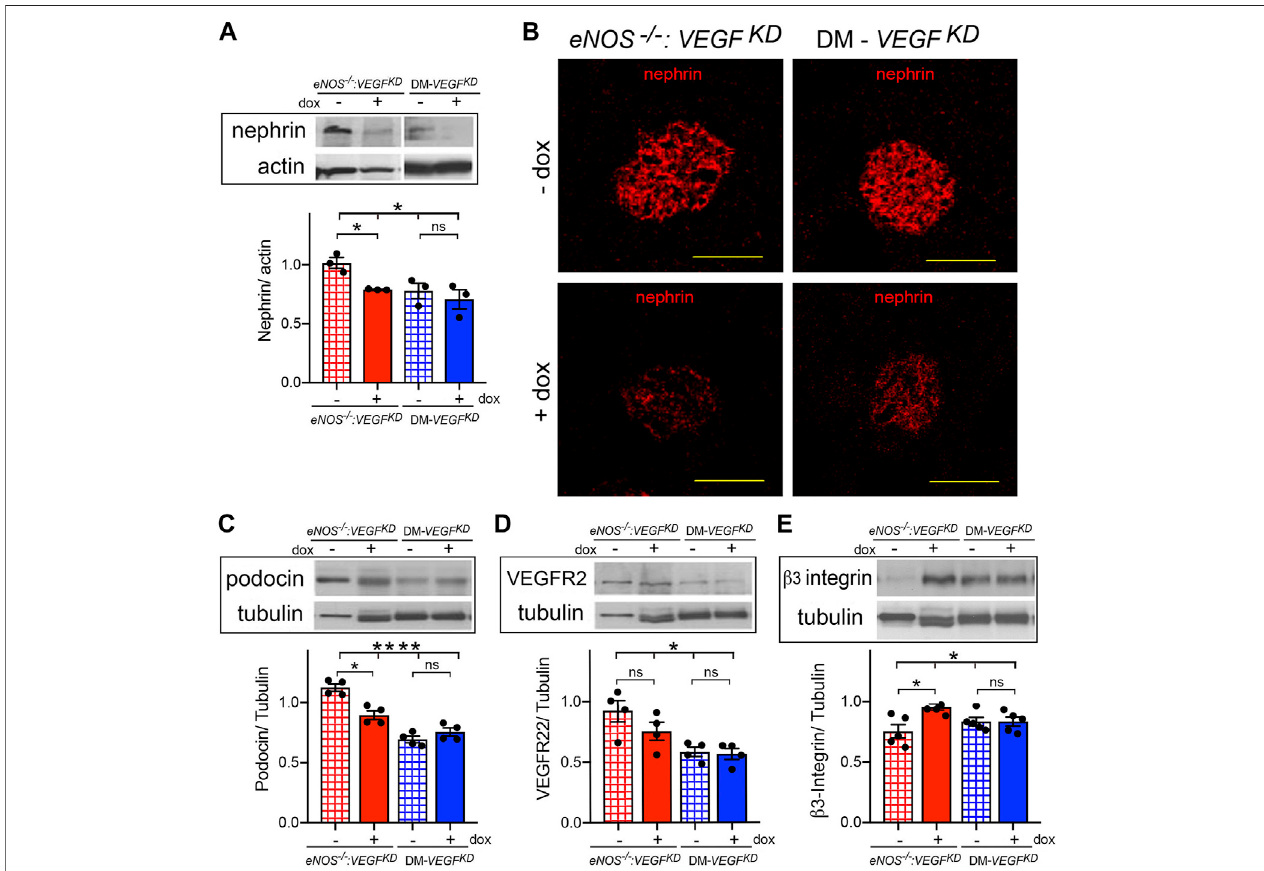
FIGURE 4 | Podocyte VEGF KD downregulates nephrin in diabetic and eNOS − / − :VEGF KD mice: (A) WB: show nephrin downregulation in eNOS − / − :VEGF KD + dox and diabetic kidneys (Brown-Forsythe ANOVA, p = 0.047), no signi fi cant difference was detected between DM- VEGF KD − dox and + dox (Welch ’ s t -test) ; (B) IHC: nephin IF signals are clearly decreased in glomeruli from eNOS − / − :VEGF KD (+dox) and DM- VEGF KD (+dox) kidneys; (C) WB: podocin decreased in eNOS − / − :VEGF KD (+dox) and diabetic kidneys (Brown-Forsythe ANOVA, p = 0.0001), no signi fi cant difference was detected between DM- VEGF KD − dox and + dox (Welch ’ s t -test); (D) WB:VEGFR2decreased in eNOS − / − :VEGF KD (+dox) and diabetic kidneys (Brown-Forsythe ANOVA, p = 0.015) but differences (+doxvs. - dox)were not signi fi cant; (E) WB: signi fi cant β 3-integrin upregulation wasdetected in eNOS − / − :VEGF KD (+dox)kidneys(Brown-Forsythe ANOVA, p = 0.03).Scale bars = 50 μ m, +dox = VEGF KD induction with